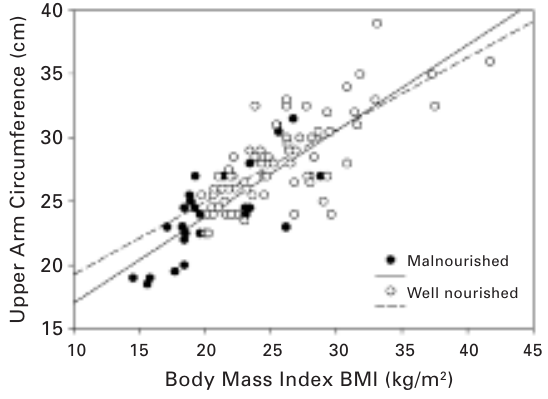
Figure 1 Correlation between body mass index and upper arm circum- ference.